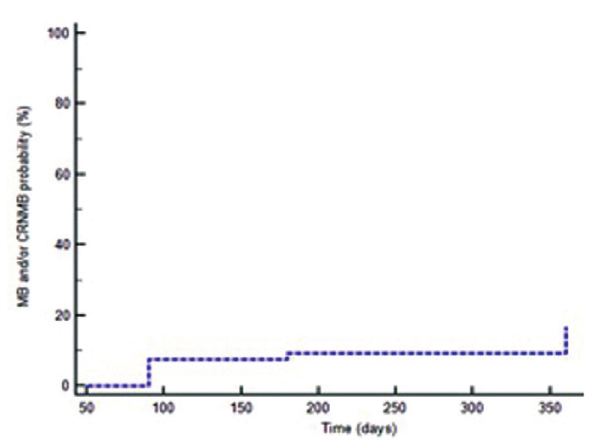
Fig. 2 Timing and incidence of major and/or clinically relevant non- major bleedings at 12-month follow-up. CRNMB, clinically relevant non-major bleeding; MB, major